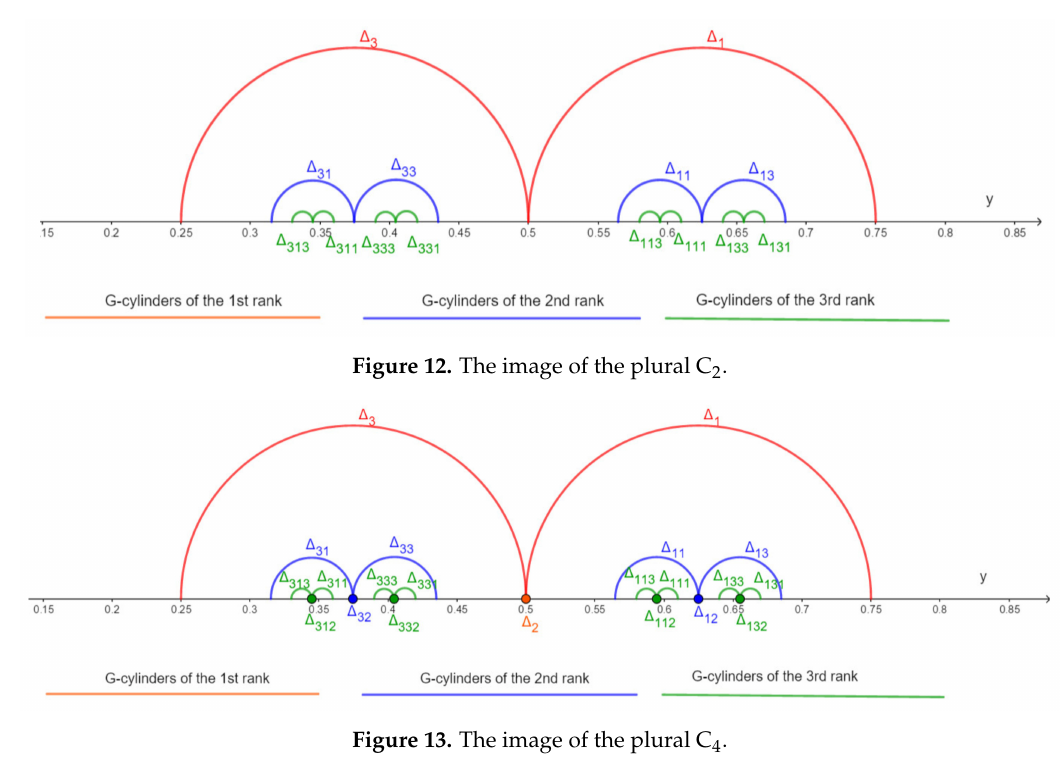
Figure 13. The image of the plural C 4 .